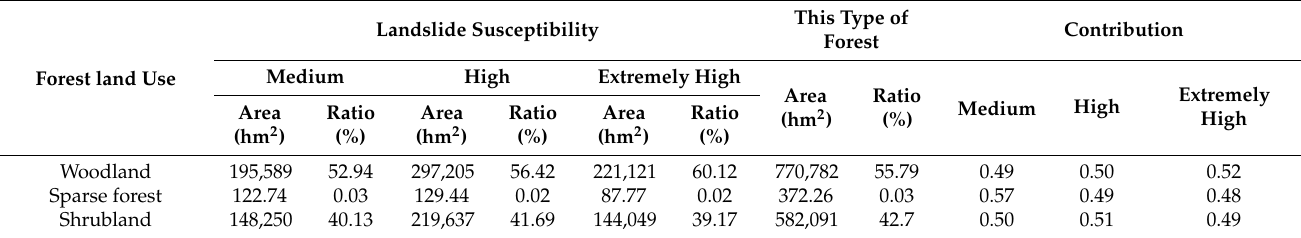
Table 1. Relationship between forest land types and landslide susceptibility in Bijie City.